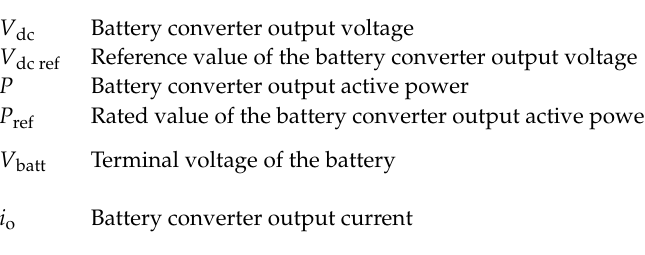
Figure 12. Experimental results for out-of-operation PV failure.